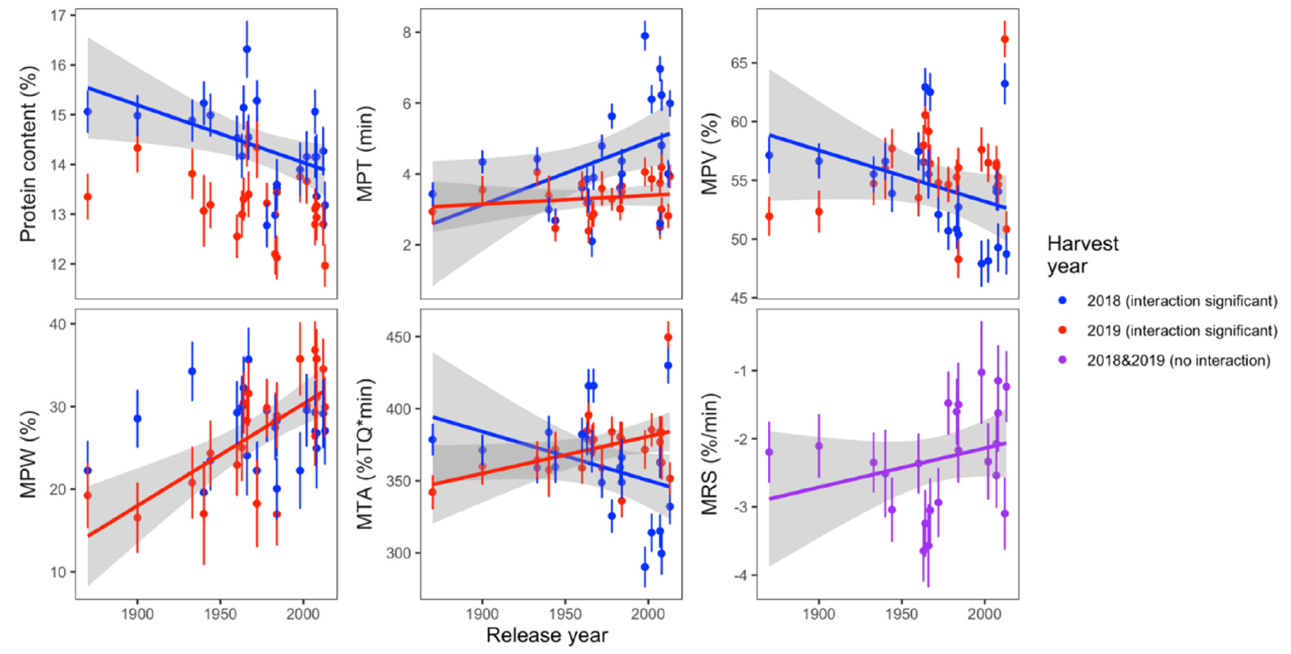
Figure 3. Protein content and mixing quality with significant trends across release year. For variables with a significant release year × harvest year interaction, least squares means are plotted by harvest year. For variables where only the main effect of release year was significant, least squares means are plotted across both harvest years. Regression lines are plotted only for data with a significant trend across release year; the gray shaded area shows the 95% confidence interval of the regression line. (MPT: Midline peak time; MPV: Midline peak value; MPW: Midline peak width; MTA: Midline time max area; MRS: Midline right slope).